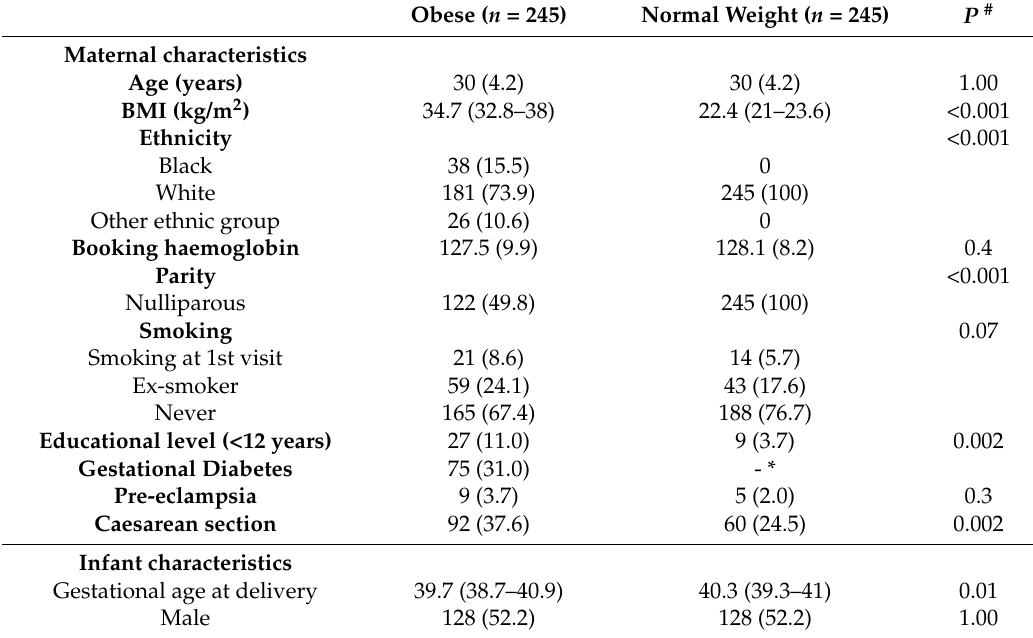
Table 1. Maternal and infant characteristics of obese ( n = 245) and normal weight ( n = 245) pregnant women. Obese ( n = 245) Normal Weight ( n = 245) P